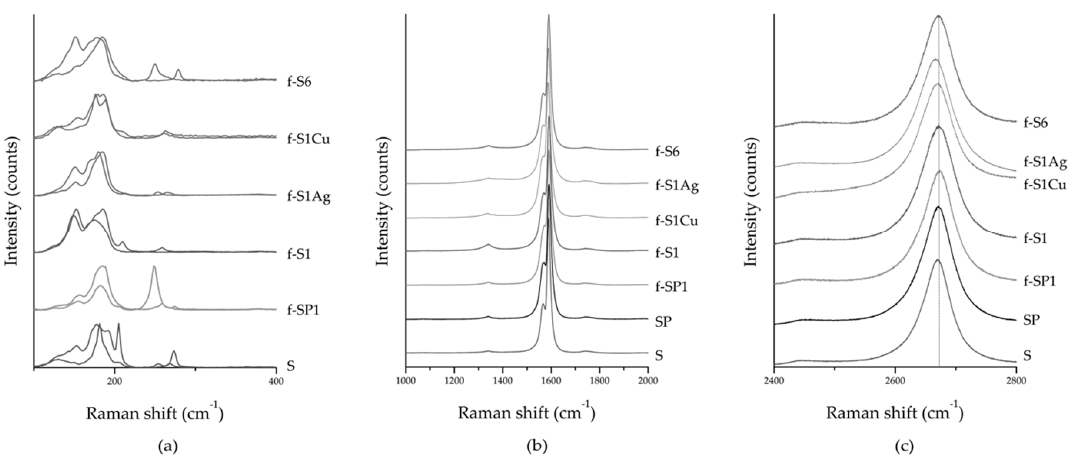
Figure 7. ( a ) radial breathing mode (RBM), ( b ) D, G, and ( c ) 2D Raman peaks of pristine, purified, f- f-SWCNT, and SWCNT, and h-SWCNT.